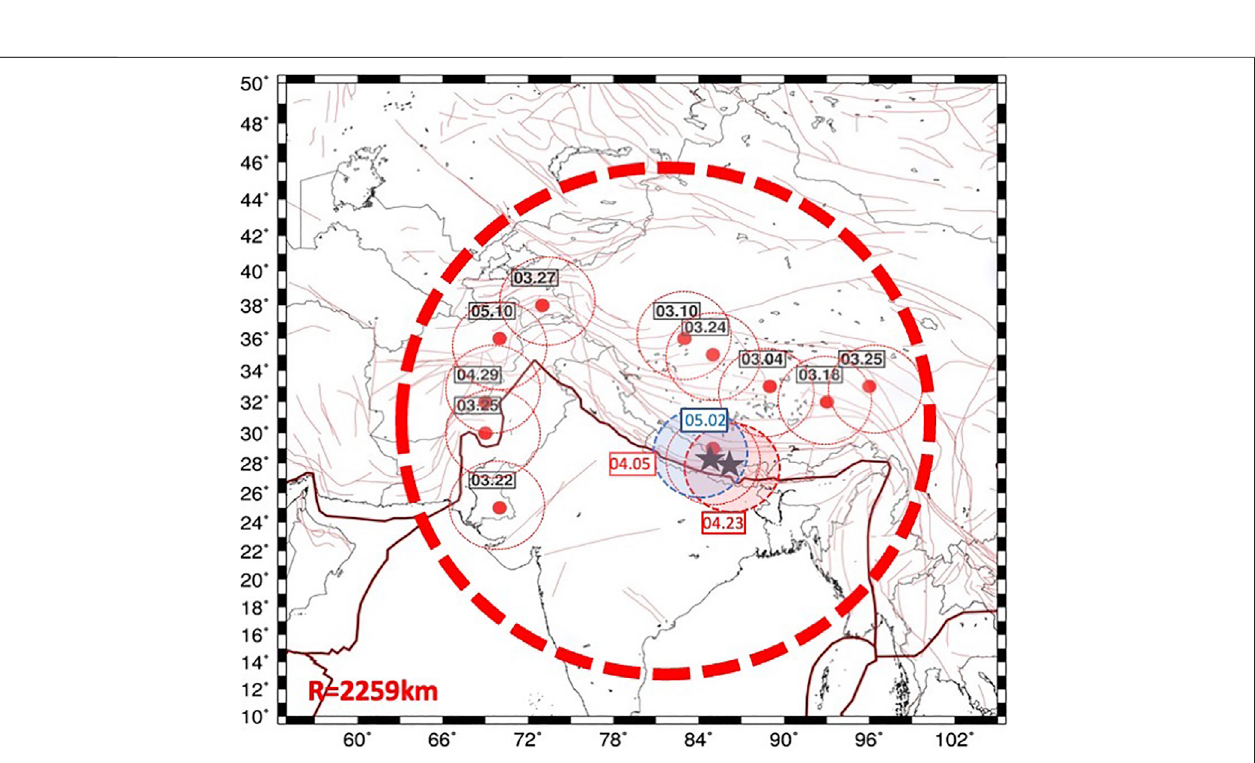
Frontiers in Earth Science |